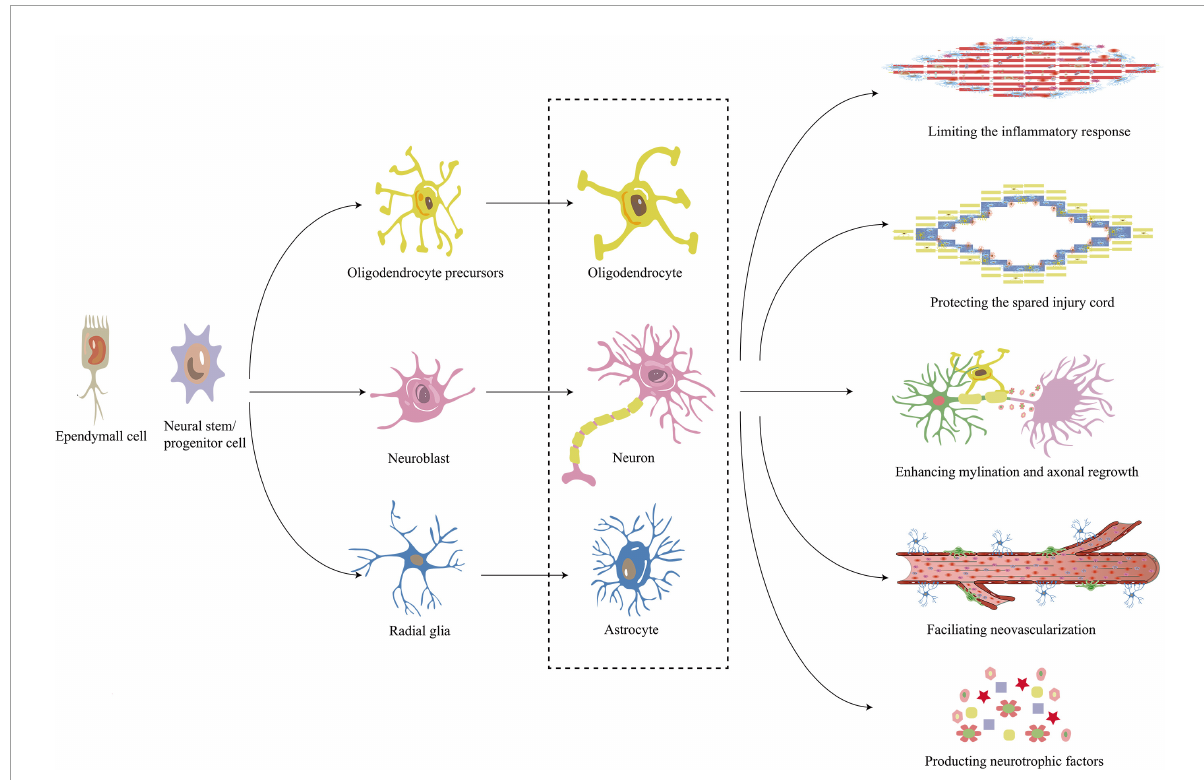
FIGURE4 Mechanism of neural stem/progenitor cell and ependymal cell in repair of SCI. Neural stem/progenitor cell and ependymal cell differentiate into neural/colloidal cell lines including oligodendrocytes, neurons, and astrocytes. These differentiated cells work together to limit the inflammatory response, protect the spared spinal cord, encourage myelination, promote neovascularization and produce neurotrophic factors to promote the repair of SCI. SCI, Spinal cord injury.